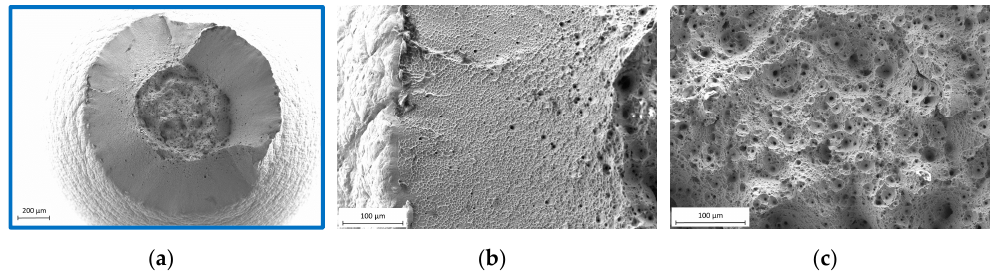
Figure 5. Fracture surface of the SSRT in air at room temperature without hydrogen charging: ( a ) ductile fracture appearance over the whole surface, ( b ) dimple structure at the edge of the sample, with clearly visible lines of deformation on the outer surface of the sample, ( c ) pure ductile structure in the center of the sample.